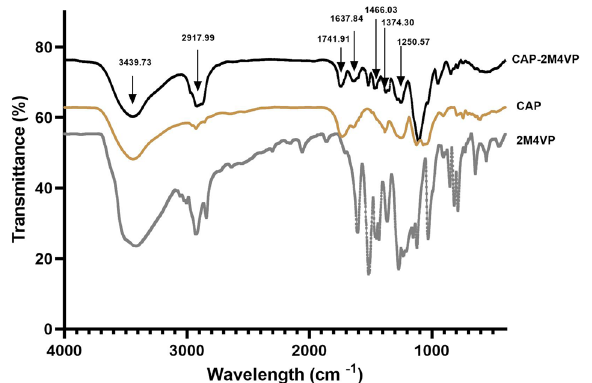
Figure 2. Comparison of Fourier-transform infrared (FTIR) spectra of pure sample 2-methoxy-4-vinylphenol (2M4VP), cellulose acetate phthalate (CAP) polymer and the cellulose acetate phthalate nano-formulation of